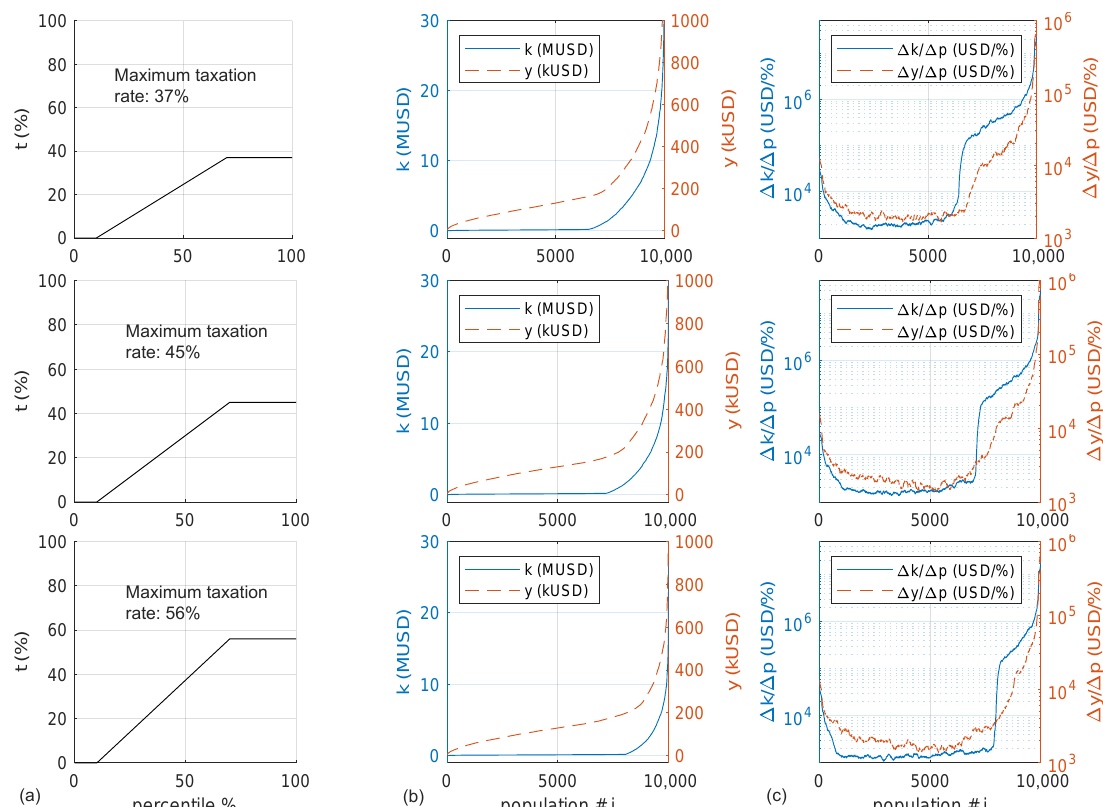
Figure 5. From top to bottom: maximum taxation rate of 37%, 45%, 56%. From left to right: ( a ) Tax rate. ( b ) Distribution of capital and income in a 1 × 10 5 population after 73 years with Keynesian tax policy. ( c ) Differentiation of the wealth with respect to wealth percentile smoothed with a mean window of size